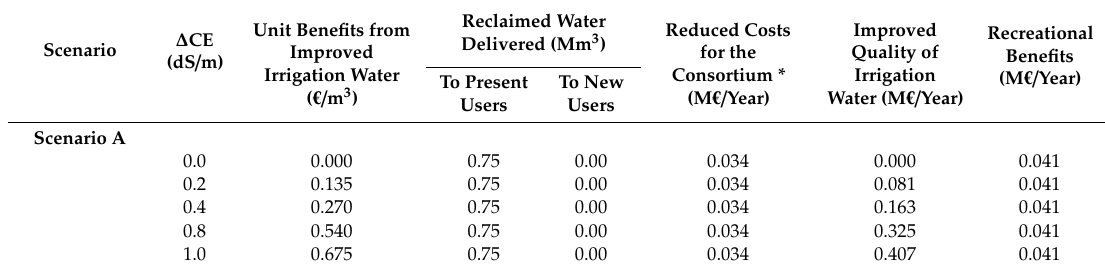
Table 6. Benefits for the three scenarios A, B and C and for various possible ∆ CE’s. ∆ CE indicates the di ff erence in saline concentration between groundwater and reclaimed water. Unit benefits from improved irrigation are obtained from the values of last column of Table 4 multiplying them by the invested areas and dividing by water requirements. Only salt-sensitive crops are considered in their evaluation, so that actual benefits are obtained from the fraction of reclaimed water used to irrigate salt-sensitive crops (81% of total